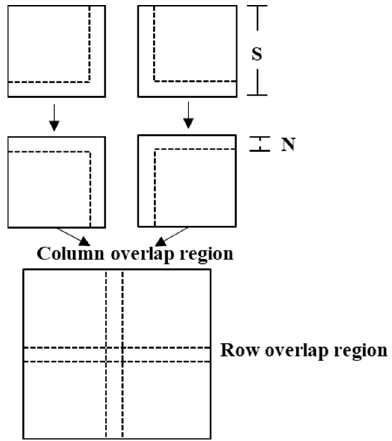
Figure 2. Four blocks with overlapping regions.